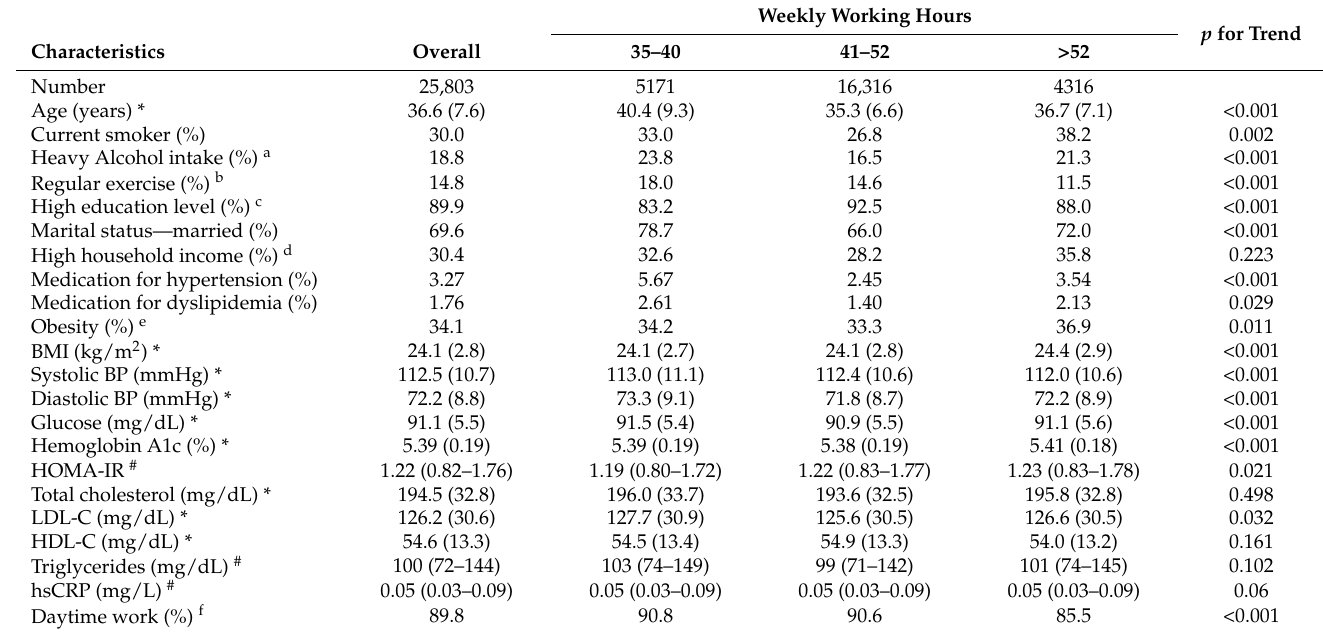
Table 1. Baseline Characteristics of study participants by weekly working